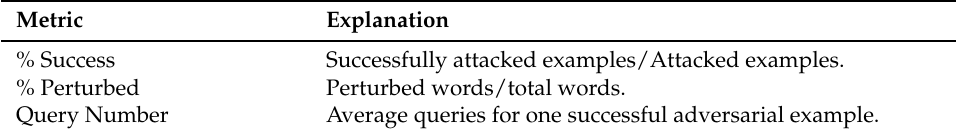
Table 7. Evaluation